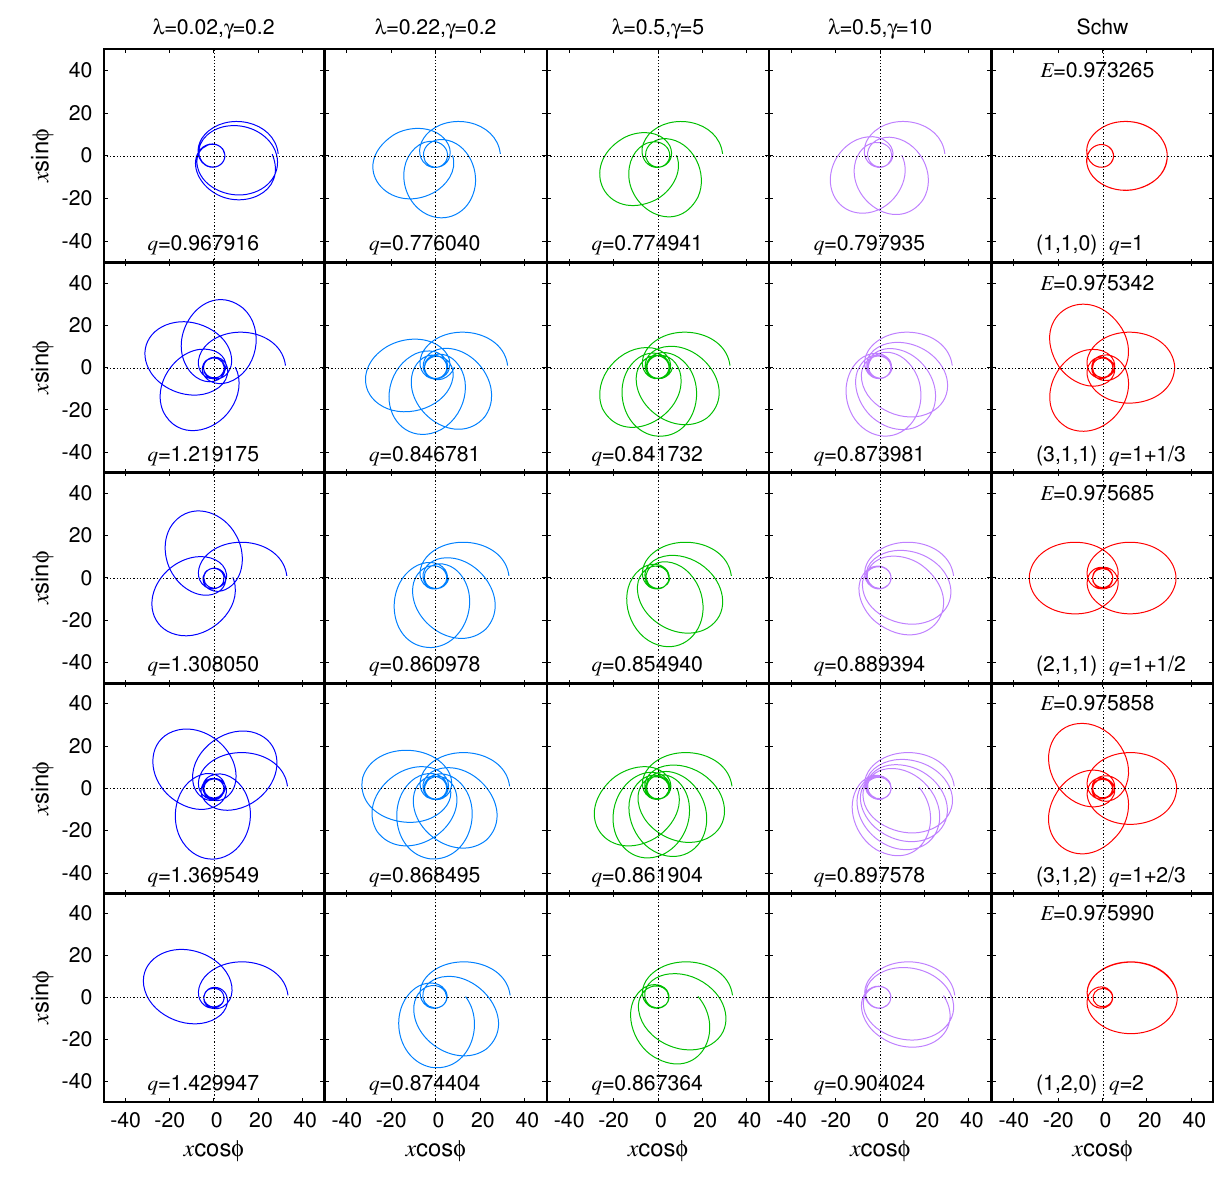
Figure 8. The quasi-periodic and periodic orbits around RGISBHs with L / M = 3.8. Each column has the same values of λ and γ , while each row shares the same value of E